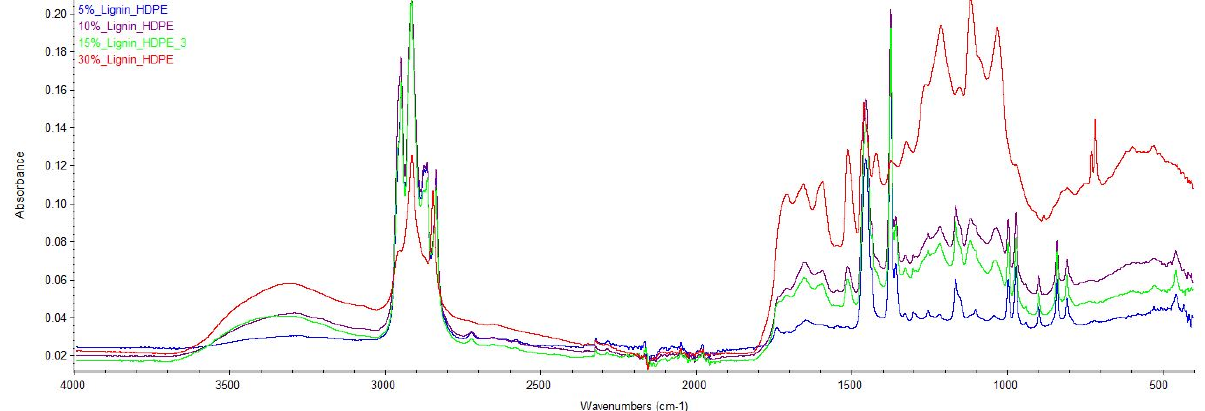
Figure 3. FTIR spectra of HDPE/lignin blends.